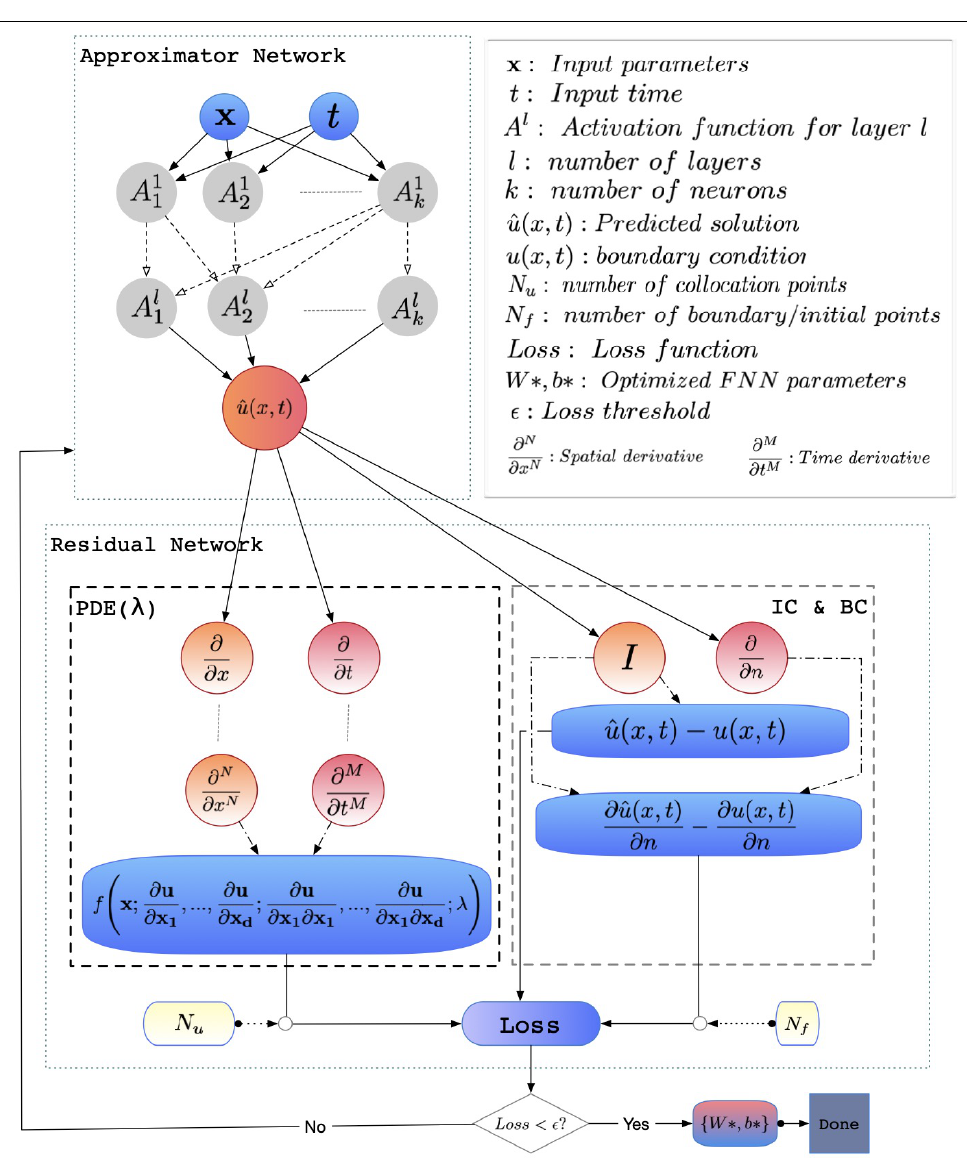
Figure 1. A PINN architecture. The "*" in the figure indicates the updated value of weights and biases. The upper-left neural network represents the approximator network that estimates the solution, ˆ u ( x , t ) of the PDE. The lower residual network forces the PDE, IC, and BC to compute the loss value. The PDE model represents an equation composed of derivatives of different